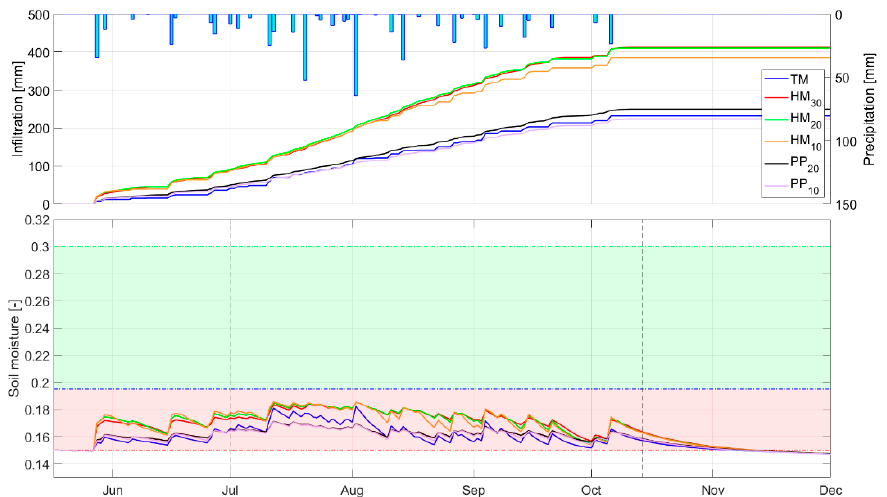
Figure 7. Precipitation (blue bars), infiltration trend, and soil moisture trend (colored lines) at the field scale over the wet season. The red area represents the level of water content lower than the threshold in which the crop is water stressed. The green area highlights the range in which soil water availability is enough to meet the demand of the crop. The boundary between the two areas corresponds to the threshold of readily available water (blue dash-dotted line). The upper and lower limits are the soil moisture at saturation and permanent wilting point, respectively. The vertical dashed lines represent the growing period, from the sowing (left) to the harvest (right). Table 6. Water stress mitigation efficiency.